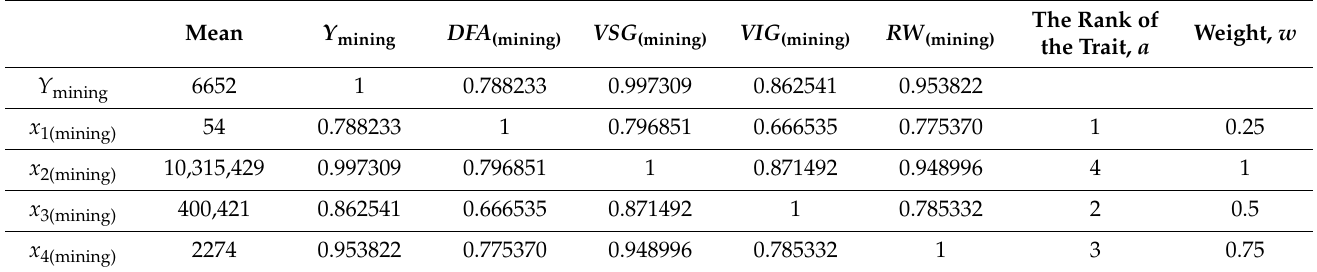
Table 1. Correlation matrix and ranking indicators the mining sector of the